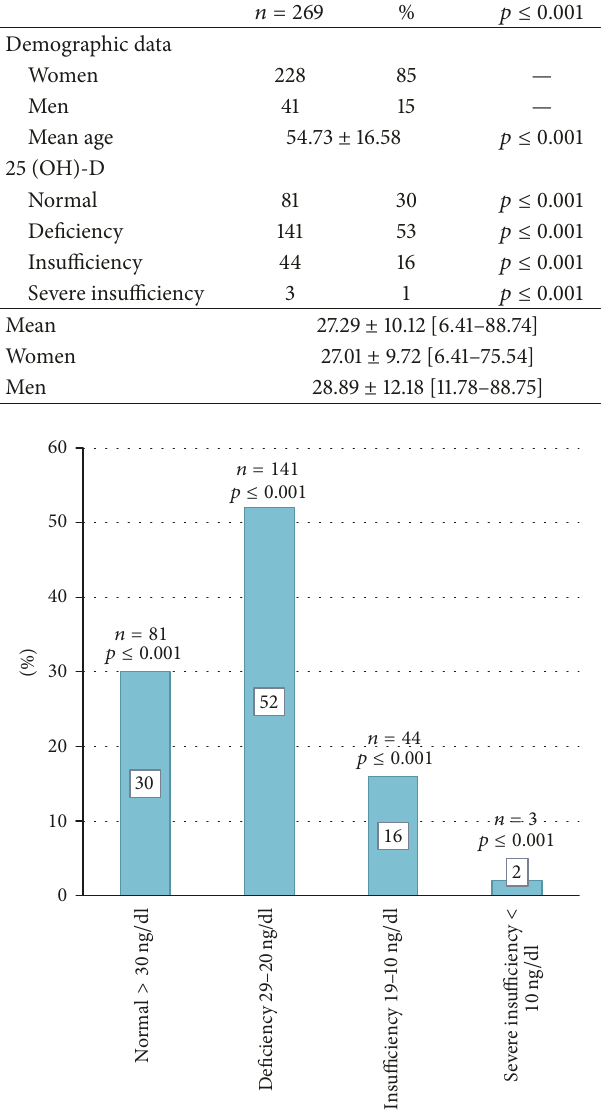
Figure 1: 25 (OH)-D levels, as indicator of vitamin D status, in Ecuadorian subjects.